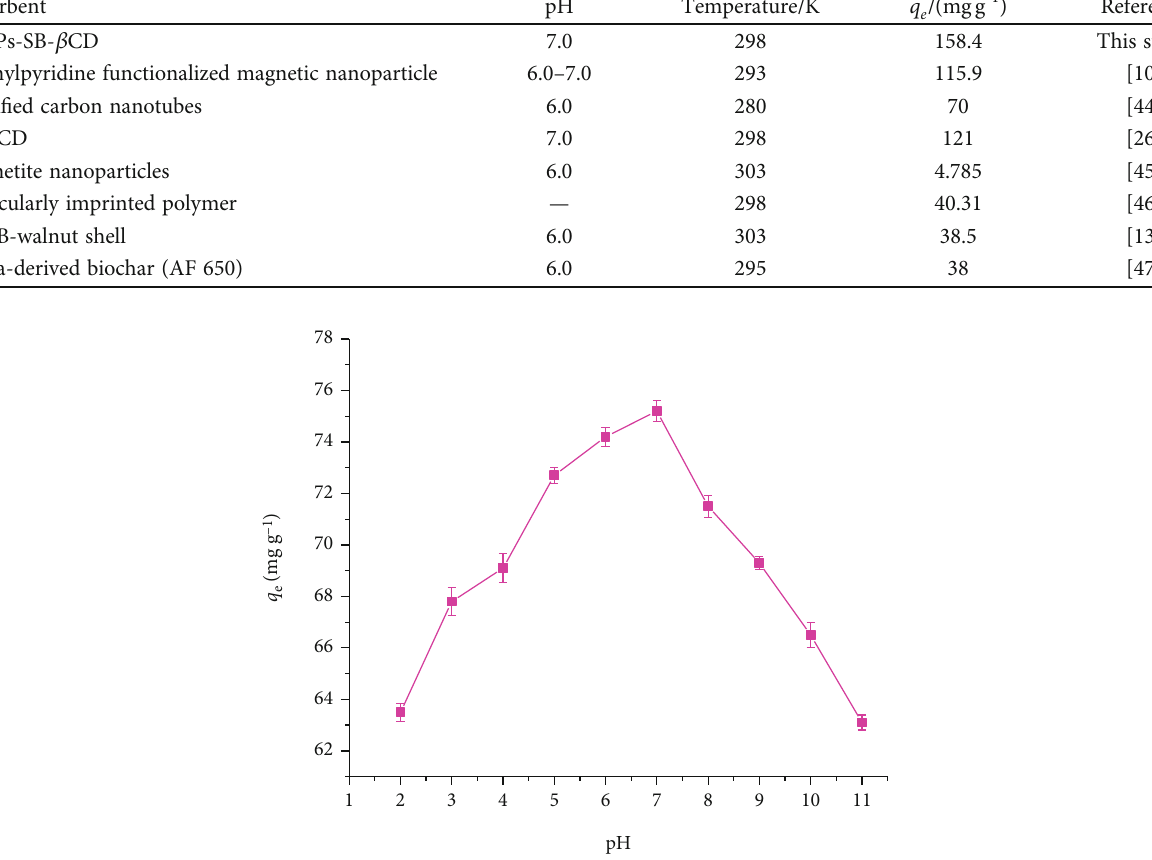
Table 5: Adsorption performance of di ff erent adsorbents towards bisphenol A removal. Adsorbent